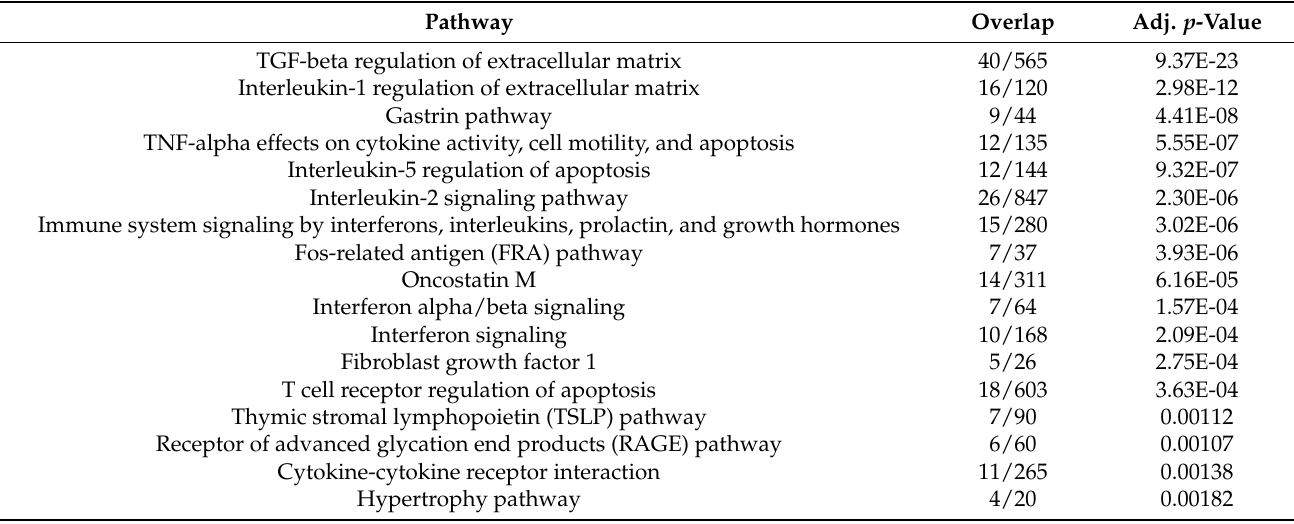
Table 1. Pathway enrichment analysis of differentially regulated genes (DRGs) between endothelial cell co-cultures and